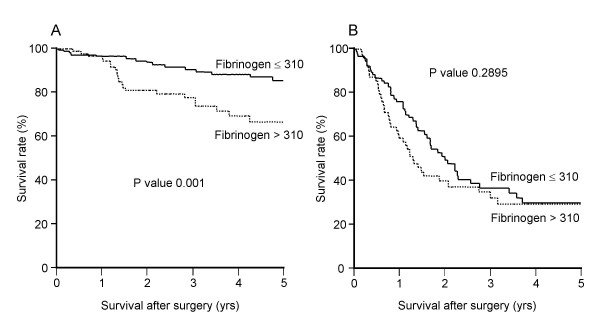
Overall survival after surgery for 240 patients with T2 gastric cancer (A) and 165 patients with T3/T4 gastric cancer (B) according to the existence of hyperfibrinogenemia. The group with hyperfibrinogenemia (>310 mg/dl) showed a significantly lower survival rate than another group (≤310 mg/dl) in T2 cancer. There was no statistically significant survival difference in T3/T4 cancer according to the plasma fibrinogen level.